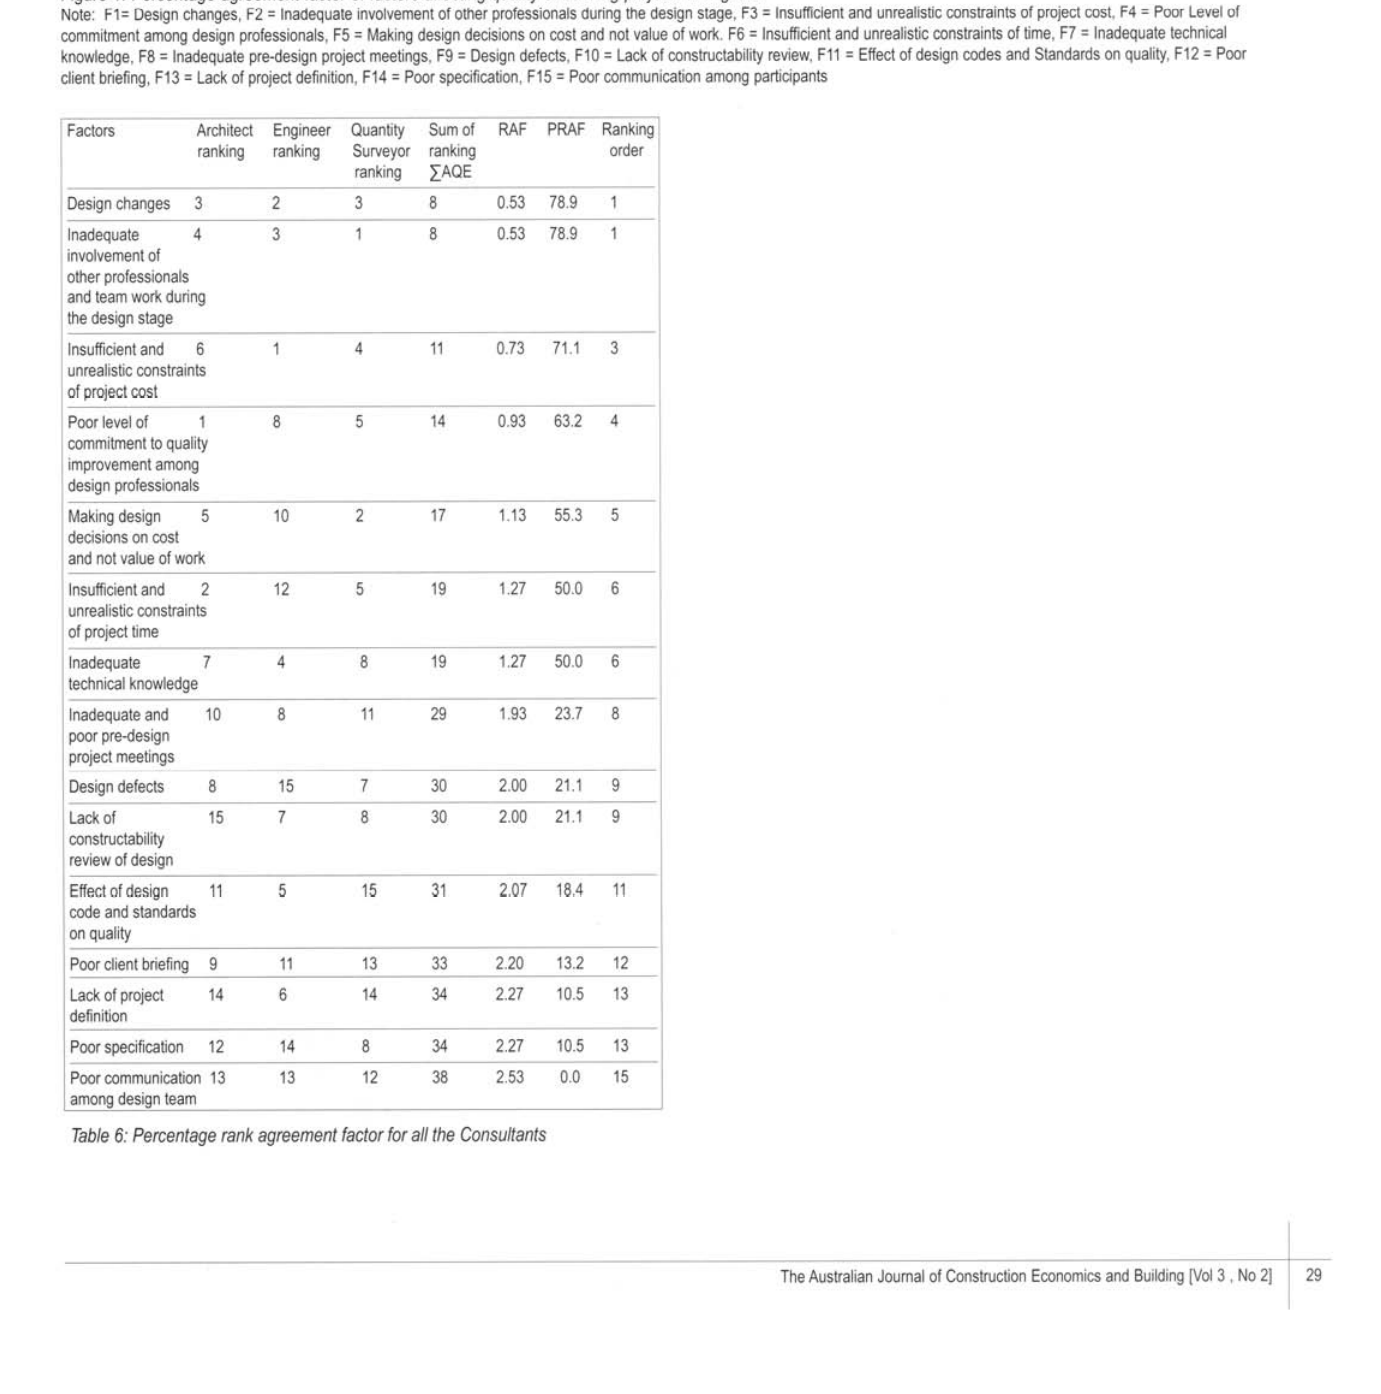
Figure 1: Percentage agreement factor of factors affecting quality of building projects in Nigeria. Note: F1= Design changes, F2 = Inadequate involvement of other professionals during the design stage, F3 = Insufficient and unrealistic constraints of project cost, F4 = Poor Level of commitment among design professionals, F5 = Making design decisions on cost and not value of work. F6 = Insufficient and unrealistic constraints of time, F7 = Inadequate technical knowledge, F8 = Inadequate pre-design project meetings, F9 = Design defects, F10 = Lack of constructability review, F11 = Effect of design codes and Standards on quality, F12 = Poor client briefing, F13 = Lack of project definition, F14 = Poor specification, F15 = Poor communication among participants